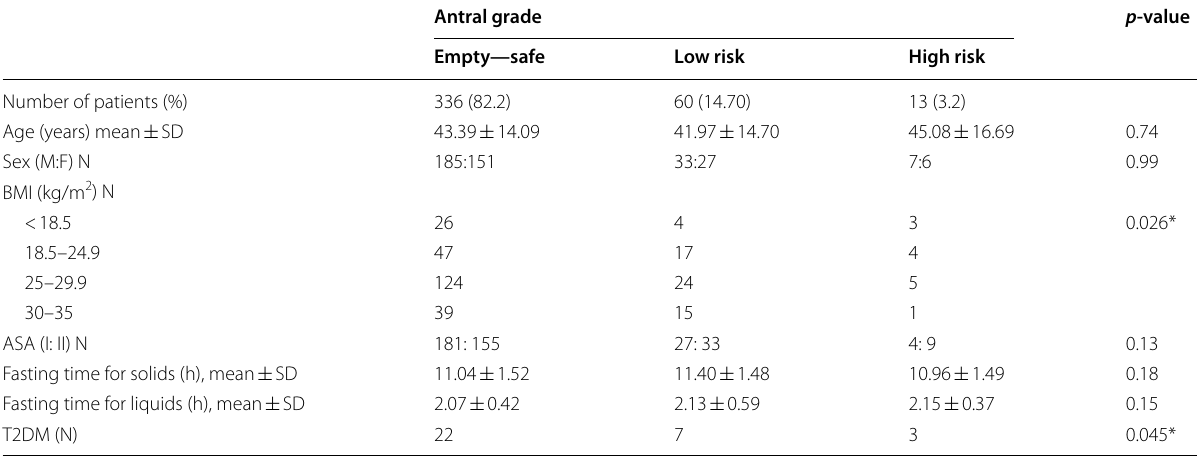
* p < 0.05 i.e. statisticallysignificant